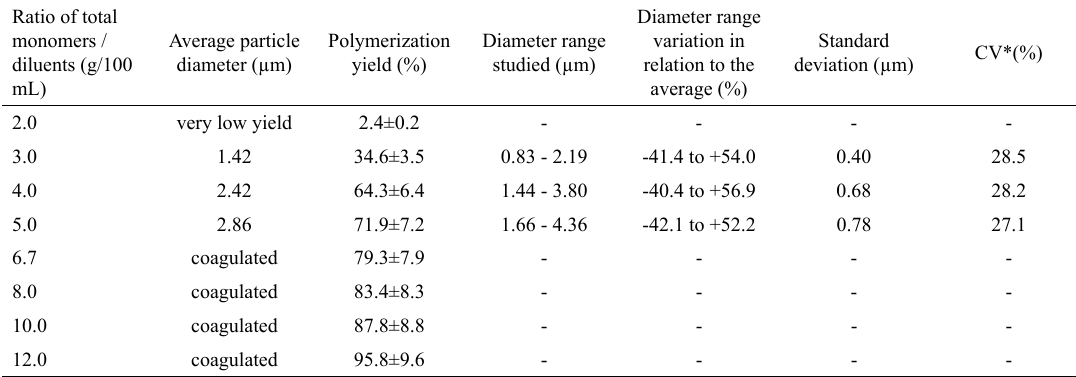
Table 3. Influence of total monomer/diluent ratio (g/100 mL) on the particles prepared with acetonitrile/toluene volumetric ratio of 75/25 and 50% MAA molar fraction Ratio of total monomers /